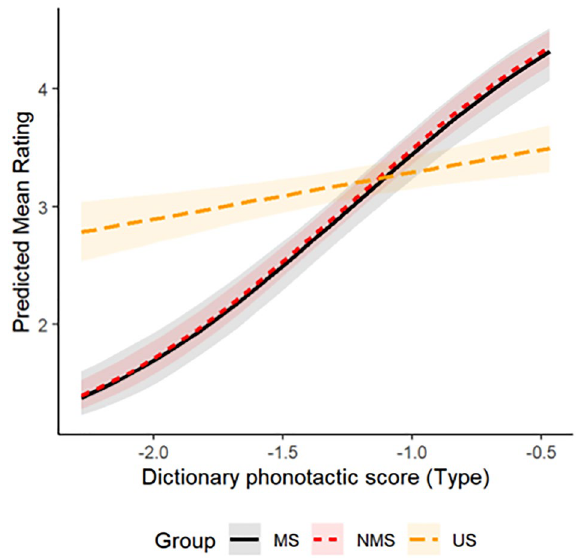
Figure 2. Interaction between dictionary phonotactic score without vowel-length distinction and three groups of